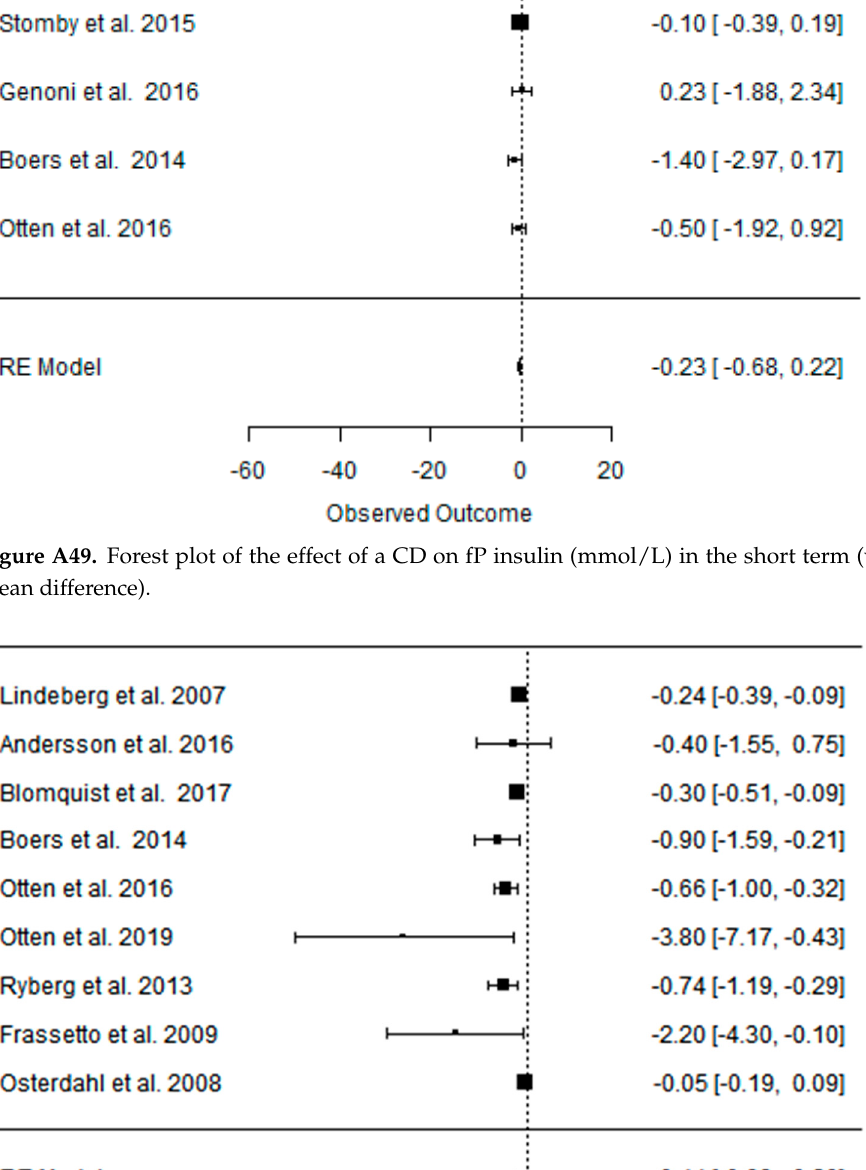
Figure A48. Forest plot of the effect of PD on fP insulin (mmol/L) in the short term (weighted mean difference).